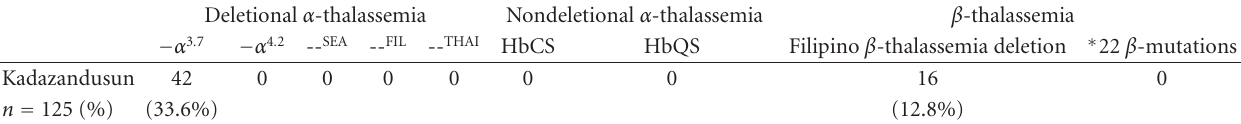
Table 1: Frequency of α - and β -thalassemia defects in the Kadazandusuns in Sabah.